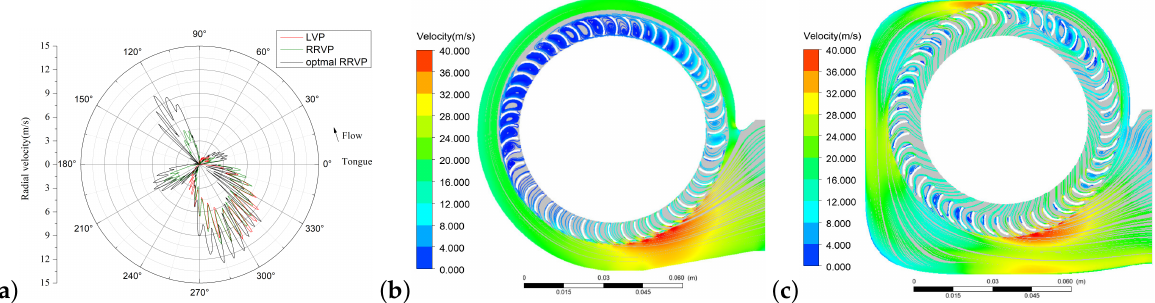
Figure 23. Comparison of impeller outlet radial velocity distribution and streamlines in section B: ( a ) radial velocity distribution, ( b ) LVP, ( c ) optimal